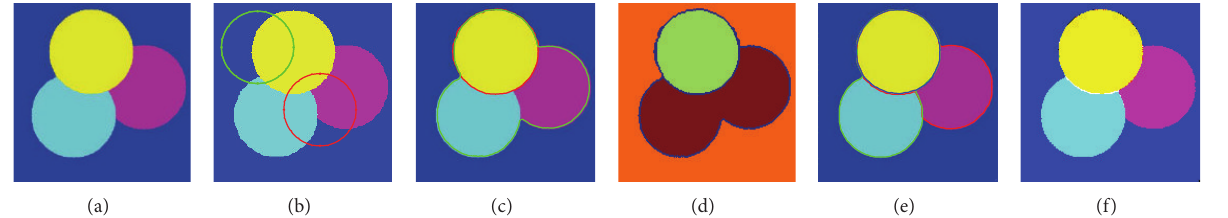
Figure 3: Results for a synthetic image; (a) original image; (b) initial contours; (c) and (d) results of the vectorial NBRACM model; (e) and (f) results of the proposed